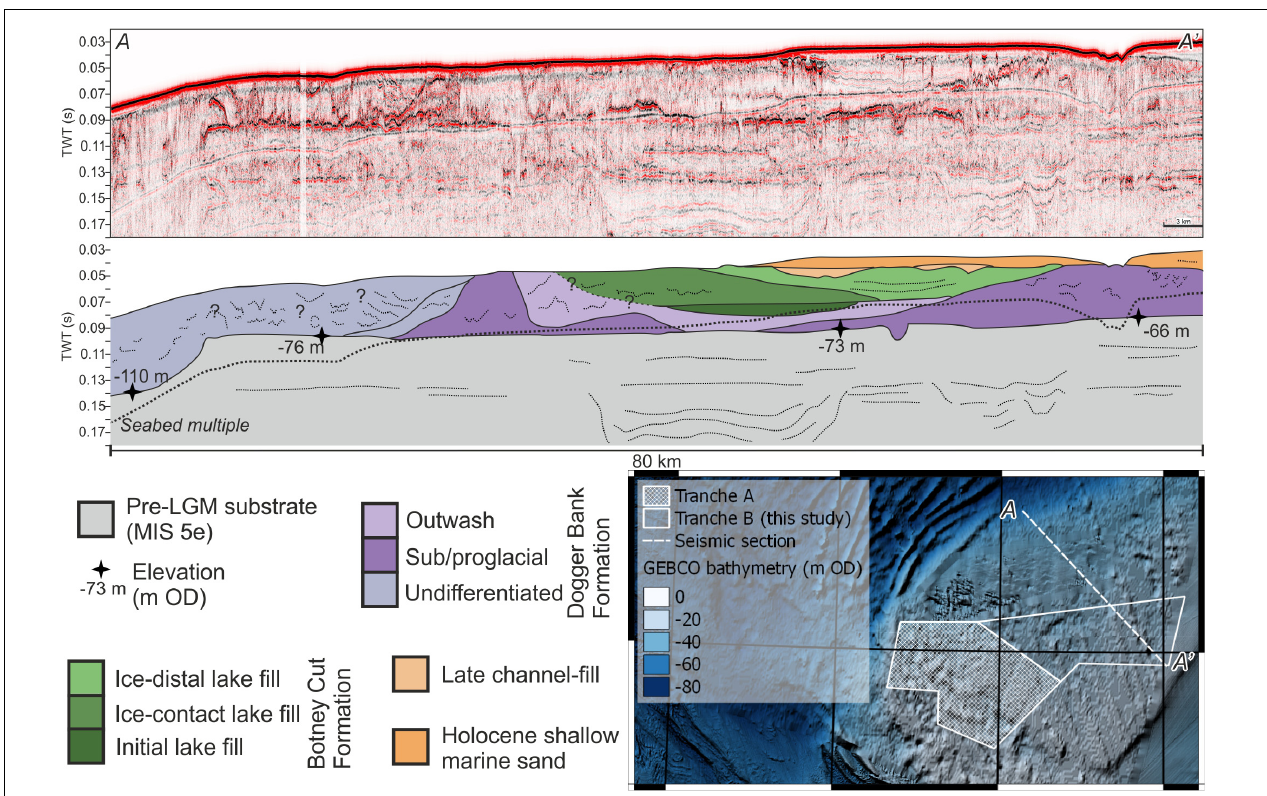
FIGURE 10 | British Geological Survey regional seismic section through Dogger Bank showing the subglacial topography toward the northern slope of Dogger Bank. Elevation of the subglacial surface deepens to the northwest and is echoed in the present-day bathymetry. No detailed seismic investigation of the northern slopes of Dogger Bank has yet been undertaken. Bathymetry data: GEBCO